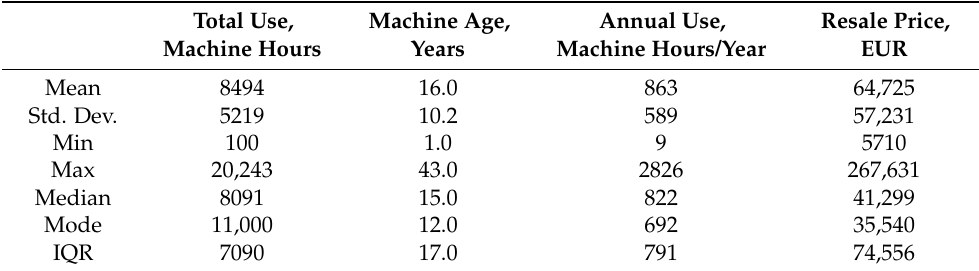
Table 3. Descriptive statistics for use, age and resale